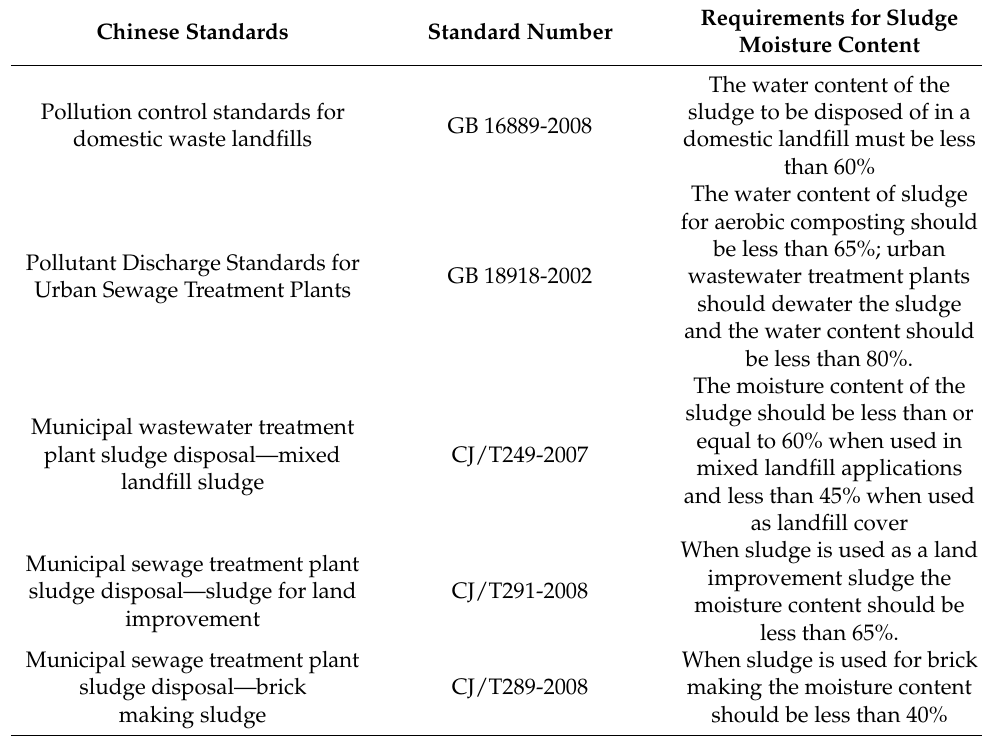
Table 1. Requirements for sludge moisture content for different treatment and disposal methods in China